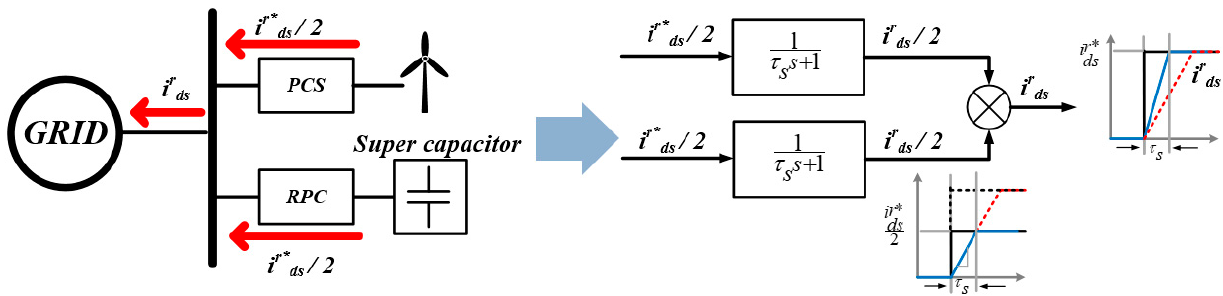
Figure 25. Response of proposed grid-connected devices for distributed generation.